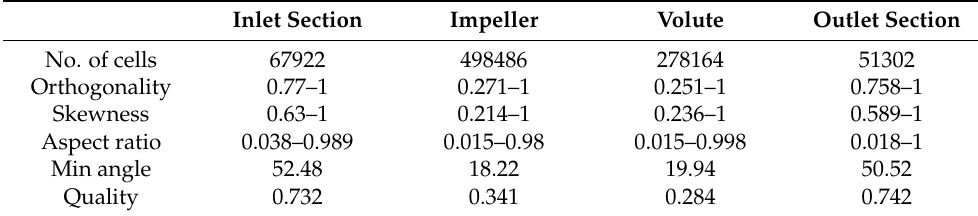
Table 3. Mesh details in each domain.